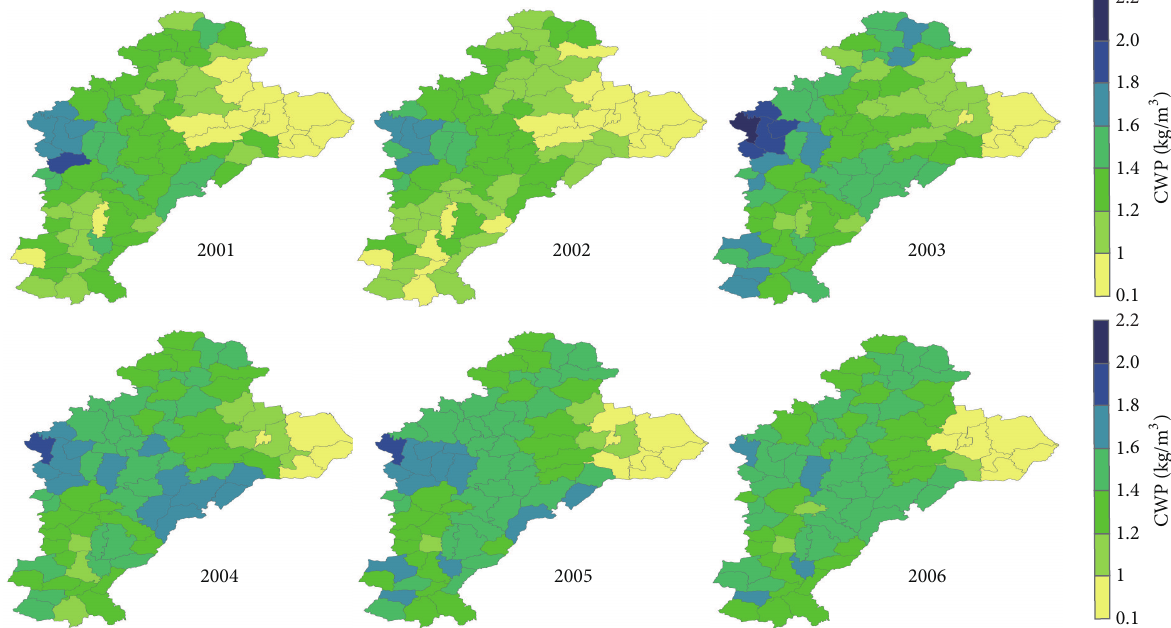
Figure 6: CWP of study area from 2001 to 2006.